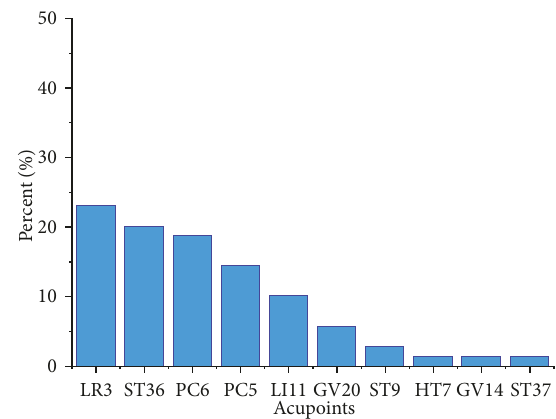
Figure 1: Acupoint selection in essential hypertension. Taichong(LR3), Zusanli(ST36), Neiguan(PC6), Jianshi(PC5), Quchi(LI11), Baihui(GV20), Renying(ST9), Shengmen(HT7), Dazhui(GV14), and